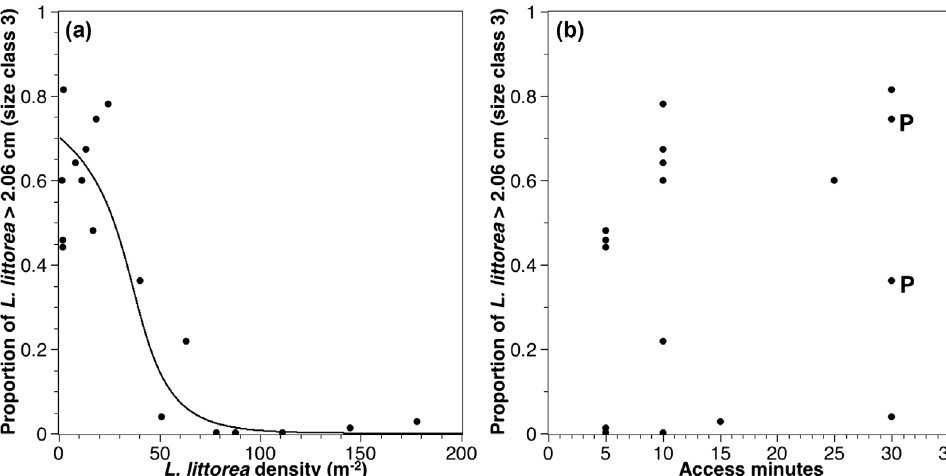
Fig. 4. (a) Proportion of a site's L. littorea population greater than 2.06cm in length (age class 3) as a function of site density. Data are pooled for all transects at a site, so surveys in different years are included. The curve represents the predictions of the size-structured model for L. littorea . (b) Relationship between the proportion of L. littorea > 2.06cm in length and the accessibility of shores to potential harvesters (as access minutes, Tab. 1). Sites where the access is across private land are indicated with “ P ”